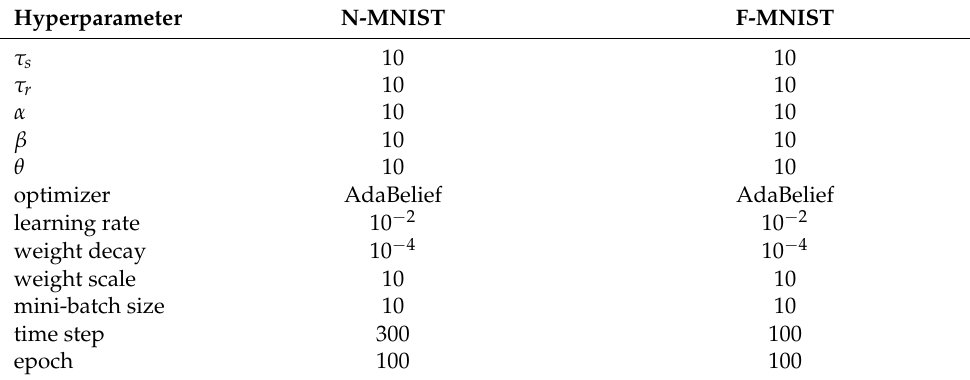
Table 1. Hyperparameter setting on N-MNIST and F-MNIST.